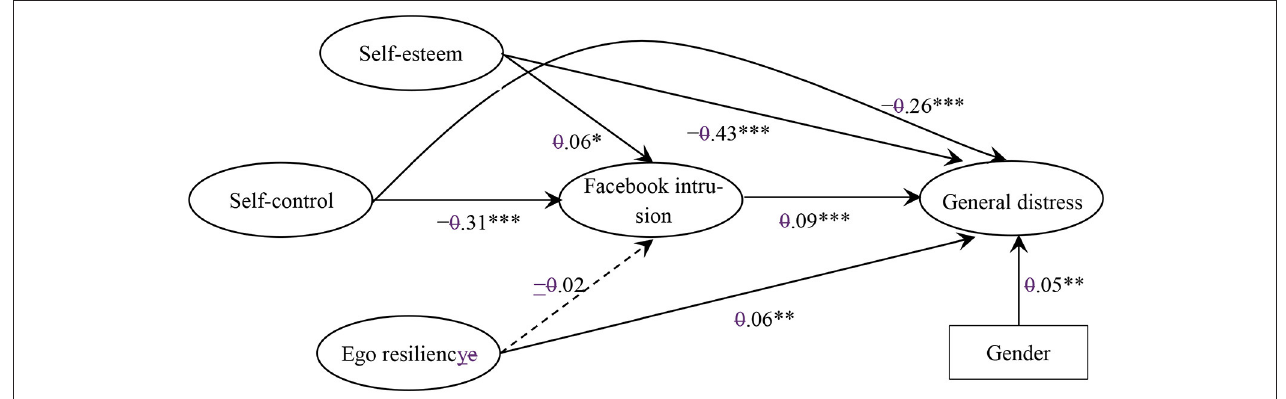
FIGURE 2 | Standardized path coefficients for the within-level structural partially mediated mode l. * p < 0.05. ** p < 0.01, *** p <